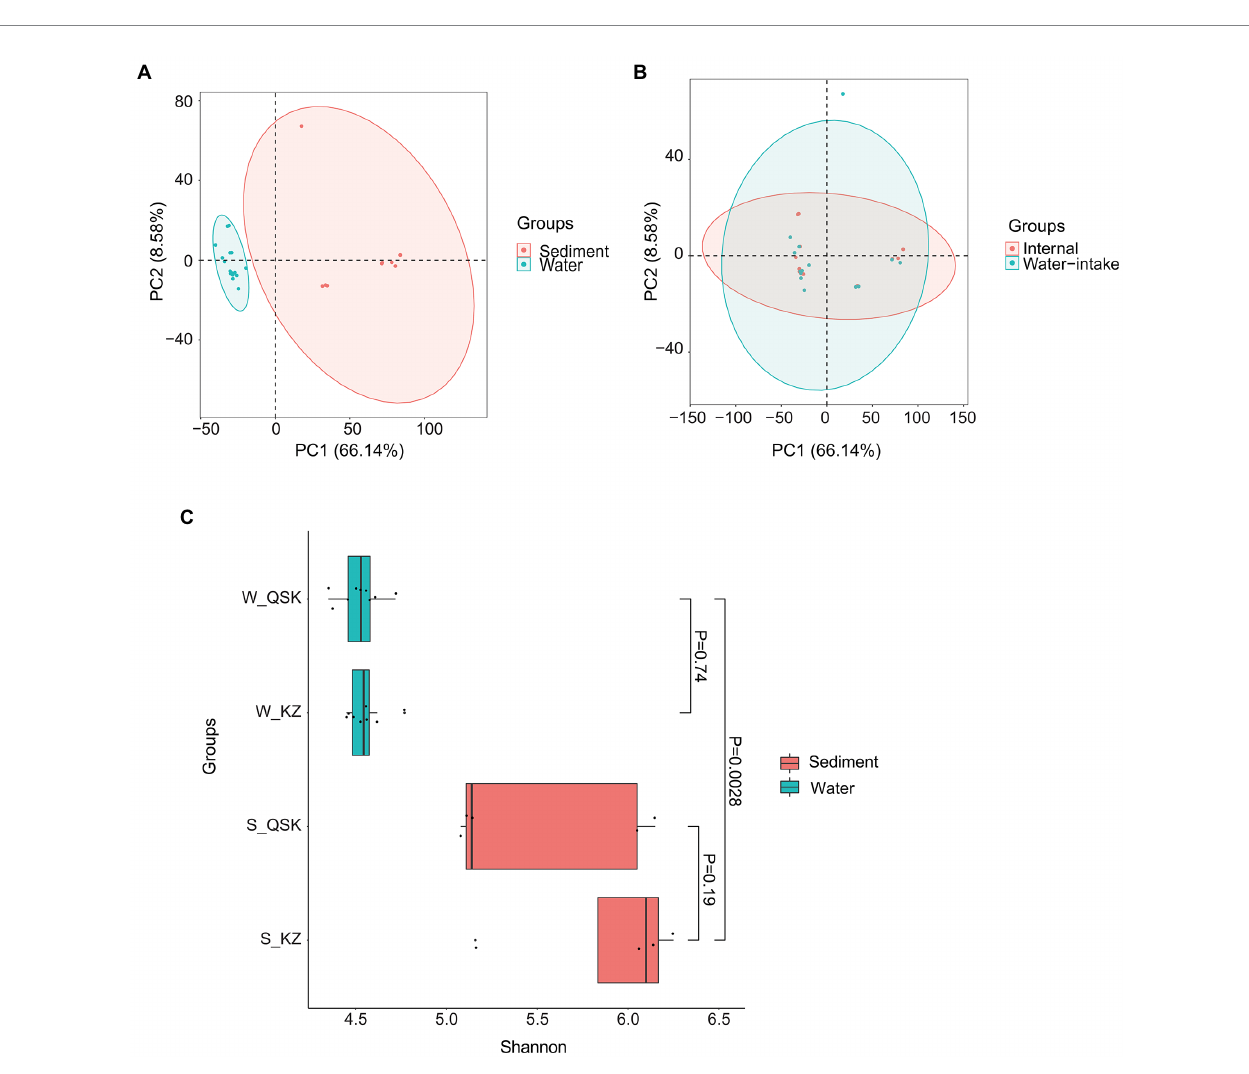
FIGURE 1 PCA and alpha diversity of sediment samples and water samples. (A) PCA of all samples, (B) PCA of water samples; (C) Shannon index of water and sediment